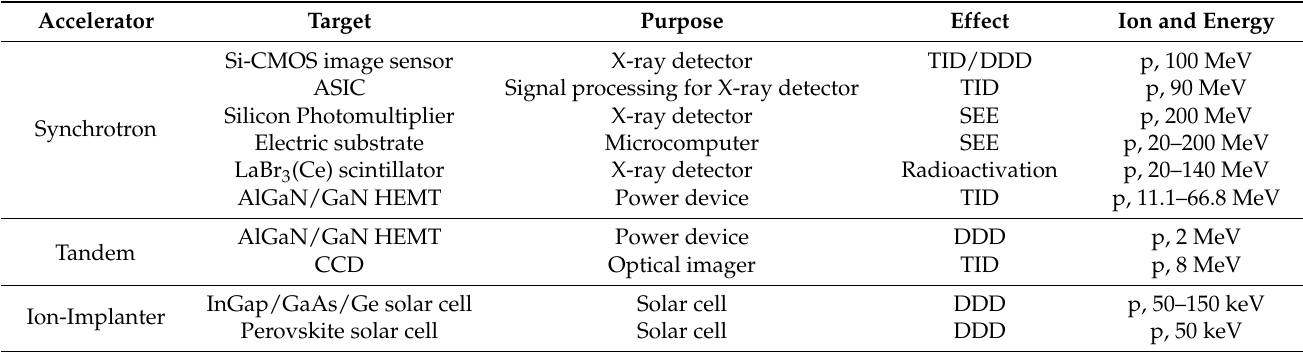
Table 4. Summary table of irradiation experiments for space electronics at